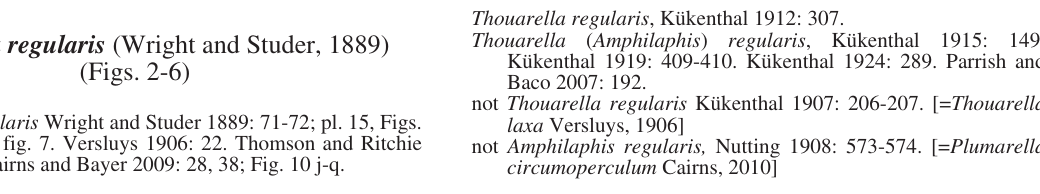
Fig . 2. – Thouarella regularis (Wright and Studer, 1889), lectotype (NHMUK 1889.5.27.60): A, whole colony; B, detail of